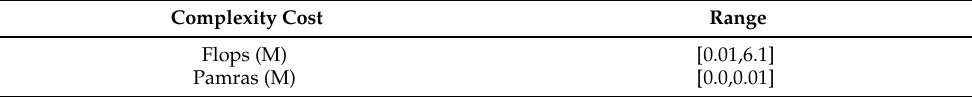
Table 7. The range of related complexity of the generated model.